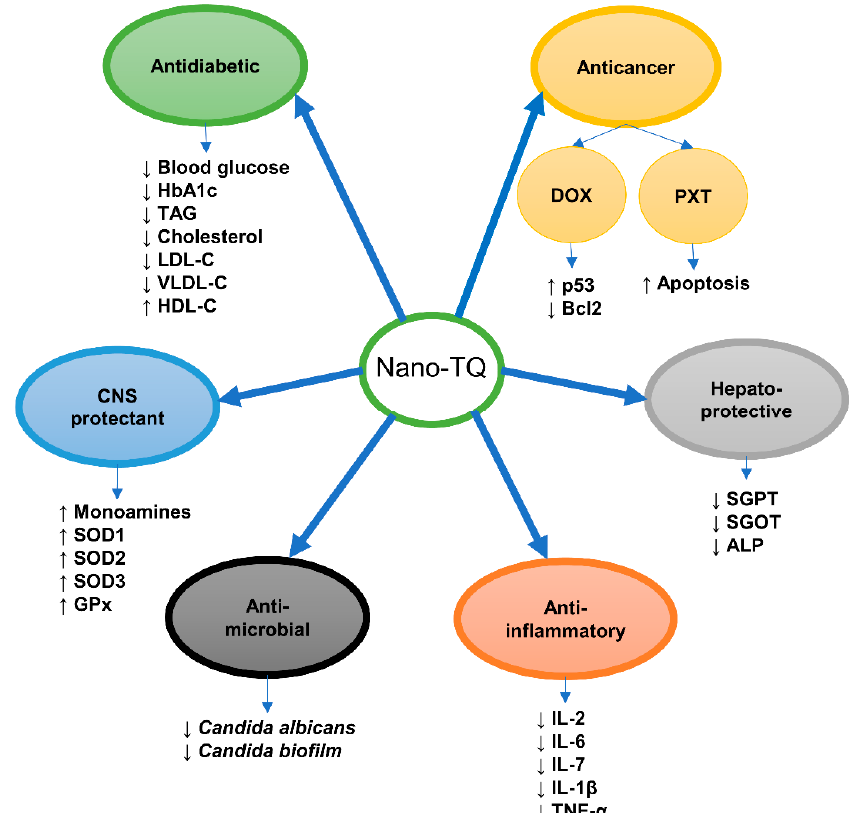
Figure 4. Biological activities of thymoquinone nanoformulations. ALP, alkaline phosphatase; Bcl2, B-cell lymphoma 2; DOX, doxorubicin; GPx, glutathione peroxidase; HbA1c, glycated hemoglobin; HDL-C, high-density lipoprotein-cholesterol; IL, interleukin; LDL-C, low-density lipoprotein-cholesterol; PTX, paclitaxel; SGOT, serum glutamate oxaloacetate transaminase; SGPT, serum glutamate pyruvate transaminase; SOD1, Copper, zinc-dependent superoxide dismutase (cytosolic); SOD2, manganese-dependent superoxide dismutase (mitochondrial); SOD3, Copper, zinc-dependent superoxide dismutase (extracellular); TAG, triacylglycerol; TNF- α , tumor necrosis factor- α ; TQ, thymoquinone; VLDL-C, very low-density lipoprotein-cholesterol.